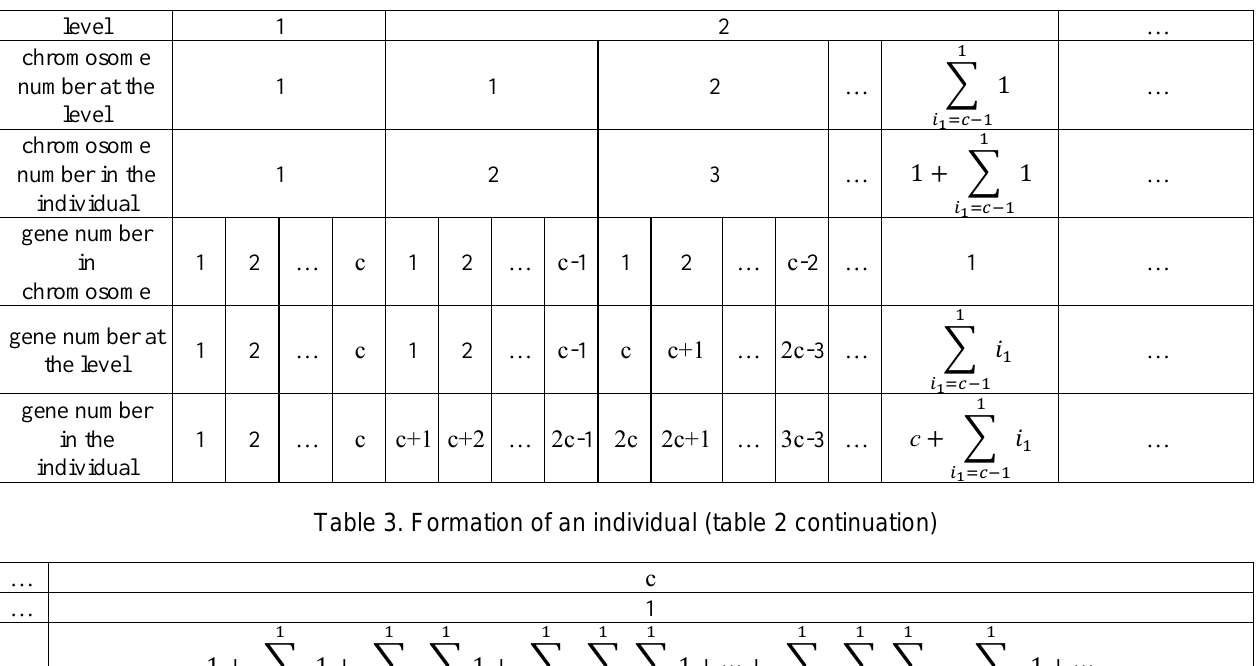
Table 2. Formation of an individual